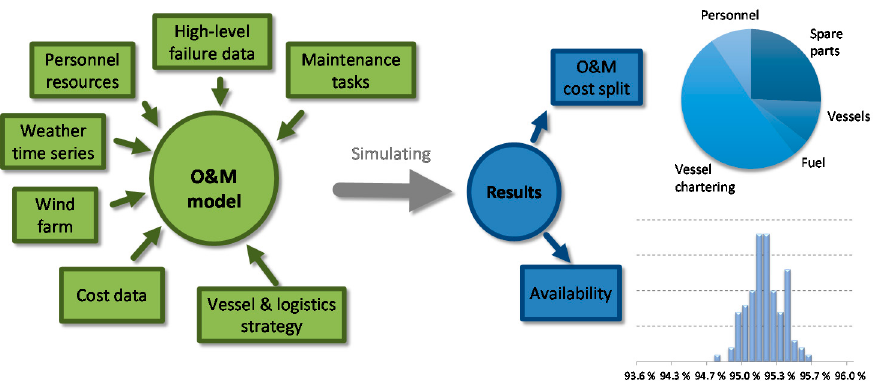
Figure 2. Typical input and output parameters of NOWIcob.